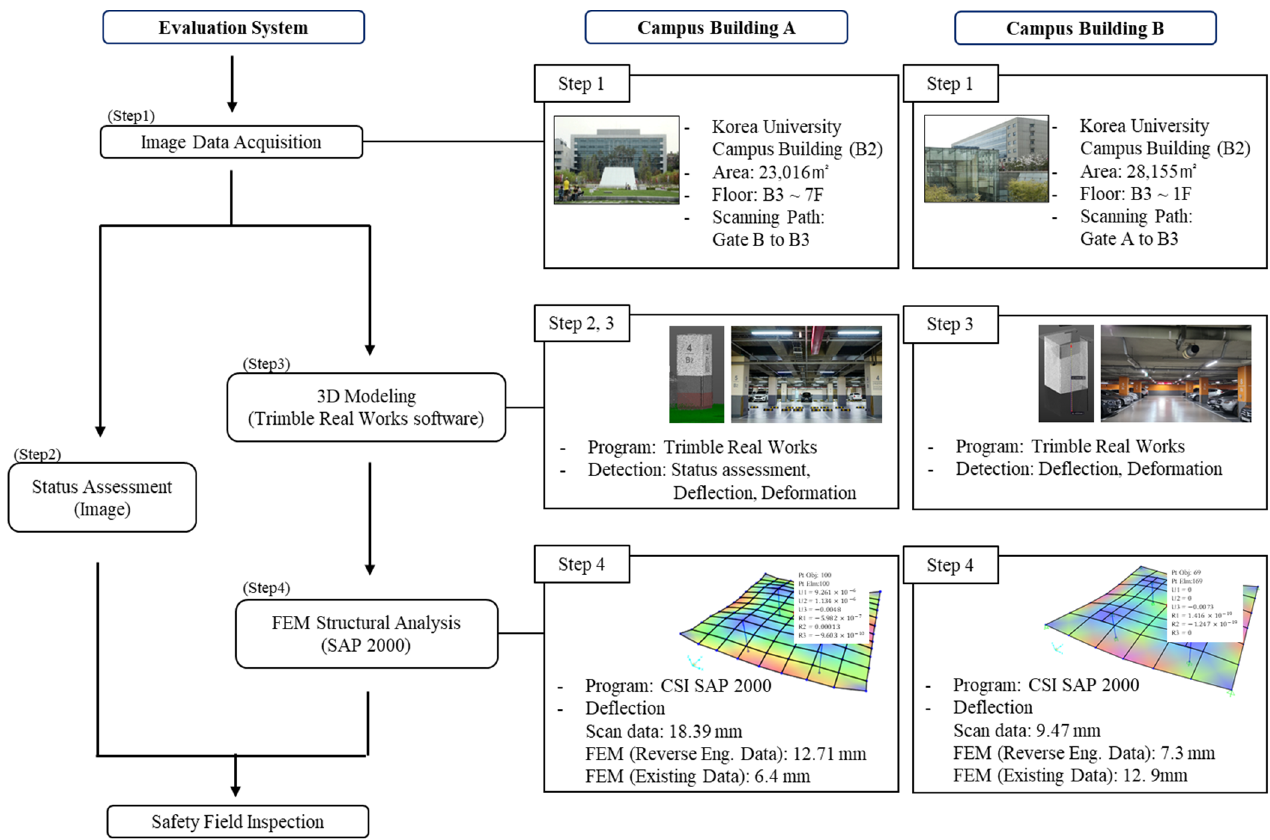
Figure 7. Summary of the evaluation system using 3D laser scanner applications (Campus Building A and B in Seoul).